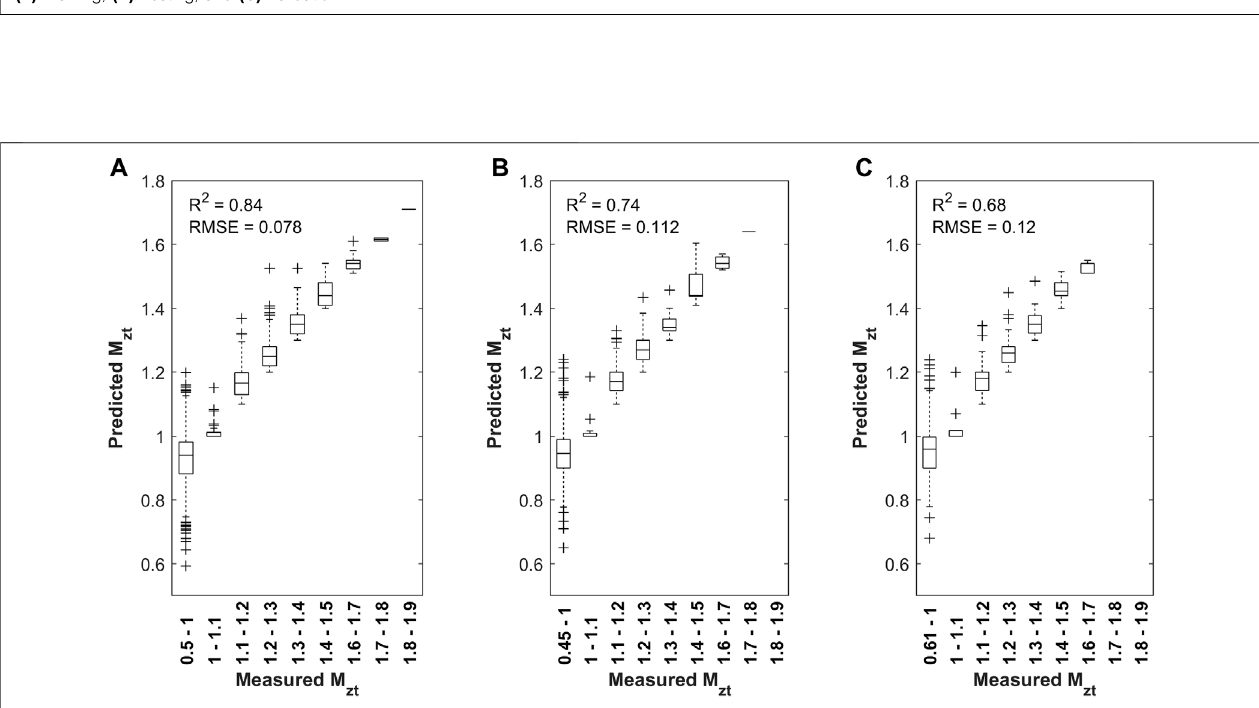
FIGURE12| Training, testing, and validationofasingle layer,150neuronmodelfor theroughterrain cases using100 m horizonal spacingDEM data. (A) Training, (B) Testing, and (C) Validation.